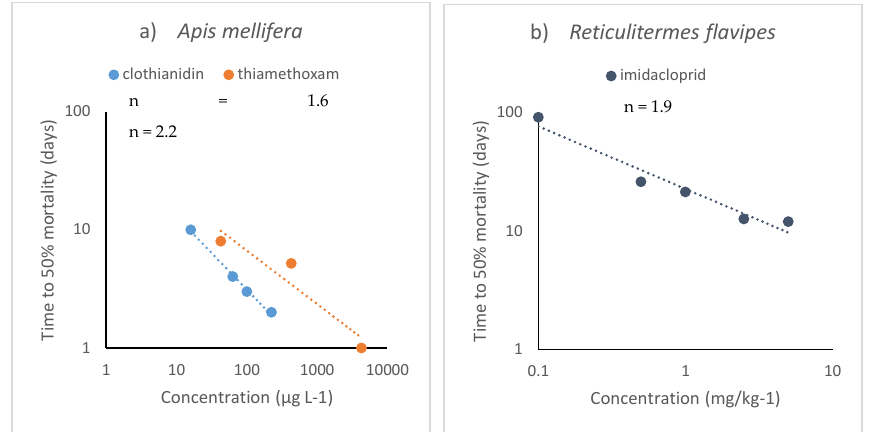
Figure 3. Examples of time-cumulative toxicity in terrestrial insects for ( a ) clothianidin and thiamethoxam on honey bees ( Apis mellifera ) [49,61]; ( b ) imidacloprid on termites Reticulitermes flavipes (sandy soil)